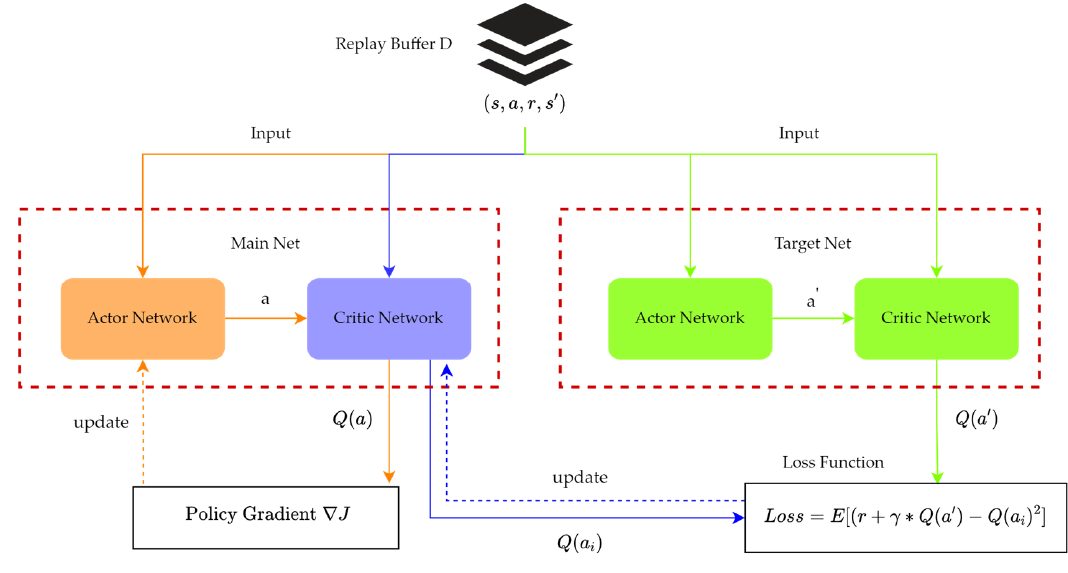
Figure 1. The DDPG